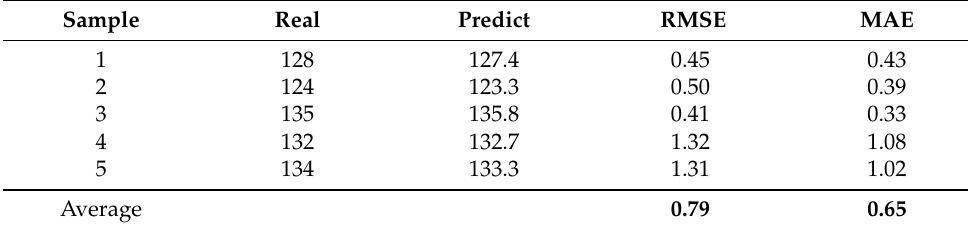
Table 5. Prediction results with the second evaluation scenario—dataset DS2.